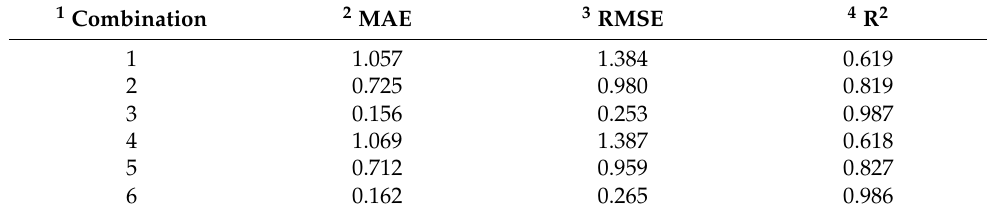
Table 6. Model accuracies of different data combinations.